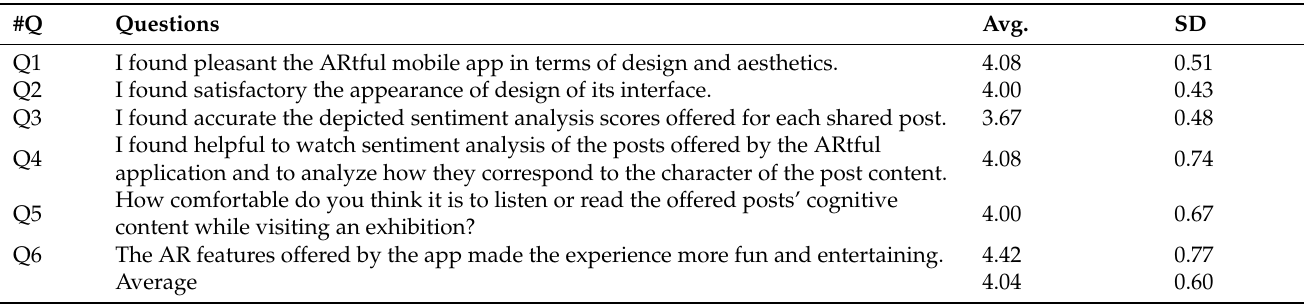
Table 5. Questions and average ratings of participants’ attitude concerning the visual appeal of the ARtful mobile app’s UI design.